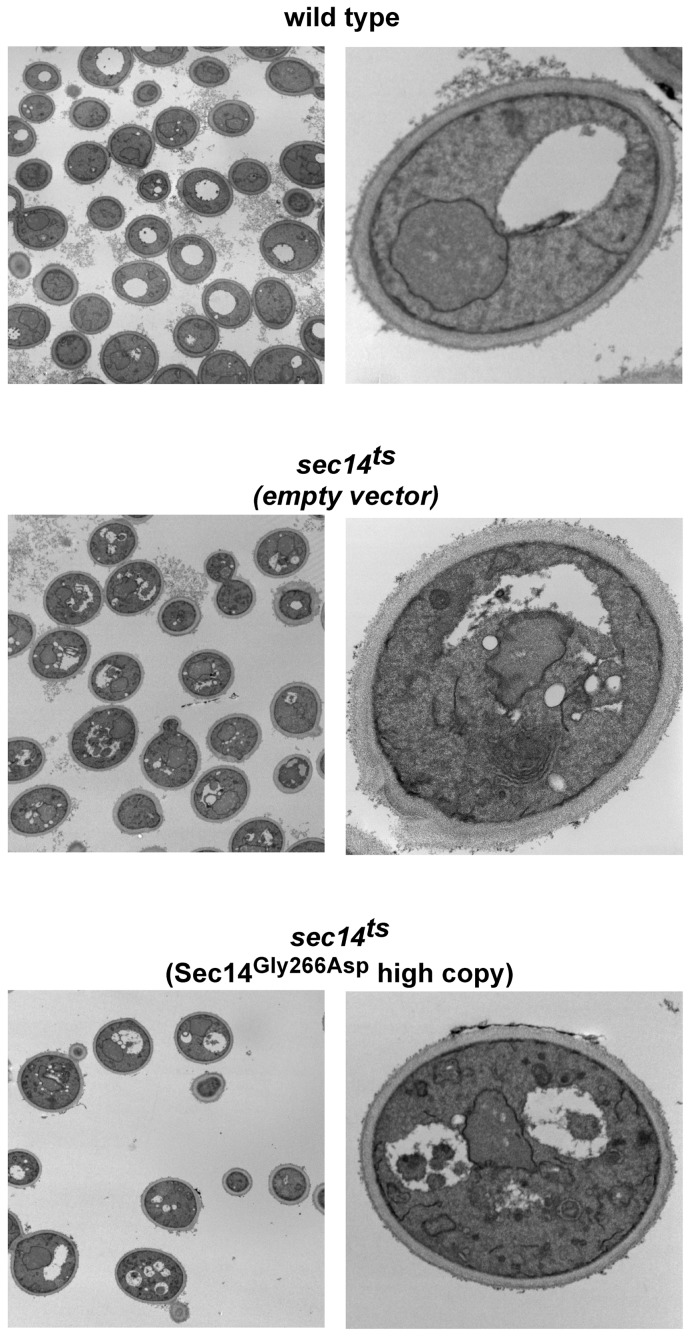
Membranes accumulate in growing cells expressing Sec14G266D.Wild type cells and sec14ts cells containing empty vector, a vector expressing wild type Sec14 on a low copy plasmid, or Sec14G266D on a high copy (2 μ) plasmid, were grown at 25°C to mid-logarithmic phase and an aliquot transferred to 37°C for 1 hr followed by incubation in 1.5% KMnO4, 1% sodium periodate, and then 1% NH4Cl subsequent to embedding and viewing by transmission electron microscopy.